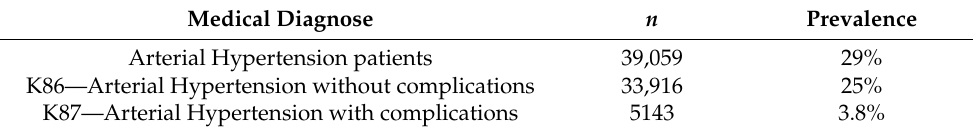
Table 1. Distribution and prevalence of medical diagnoses in hypertension patients.